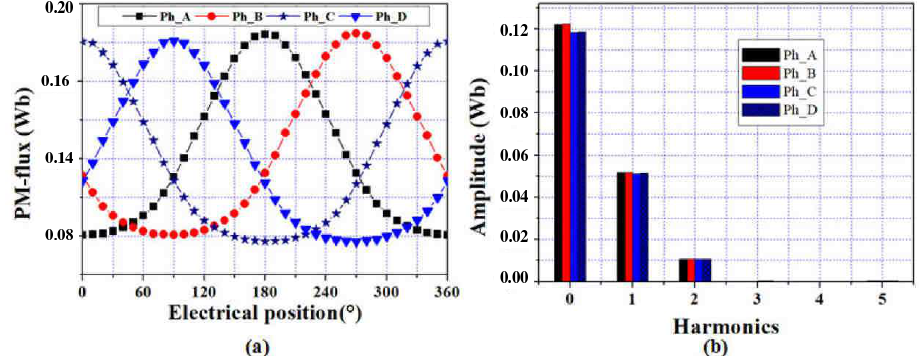
Figure 9. PM-flux and FFT spectra of 4-phase with two coils/phase: ( a ) PM-flux, ( b ) FFT spectra.